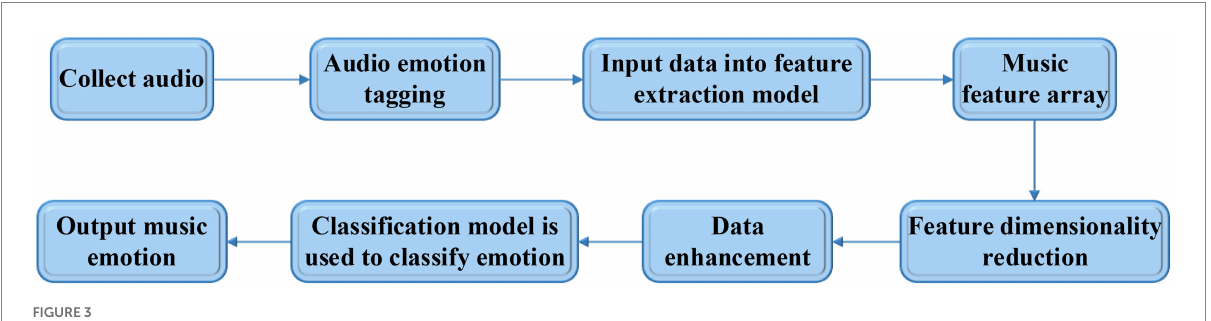
FIGURE 3 Flow chart of music emotion